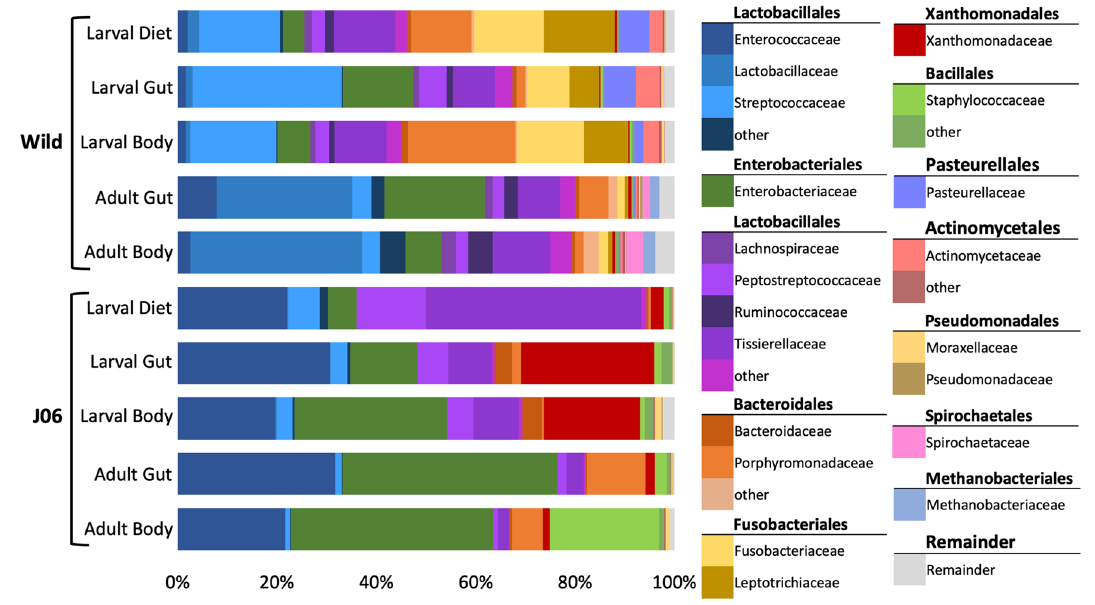
Figure 4. Stacked bar plots showing the composition of the average microbial community in each sample type with taxonomic classification shown to the family level. The top 12 most abundant orders and the families present within are shown.